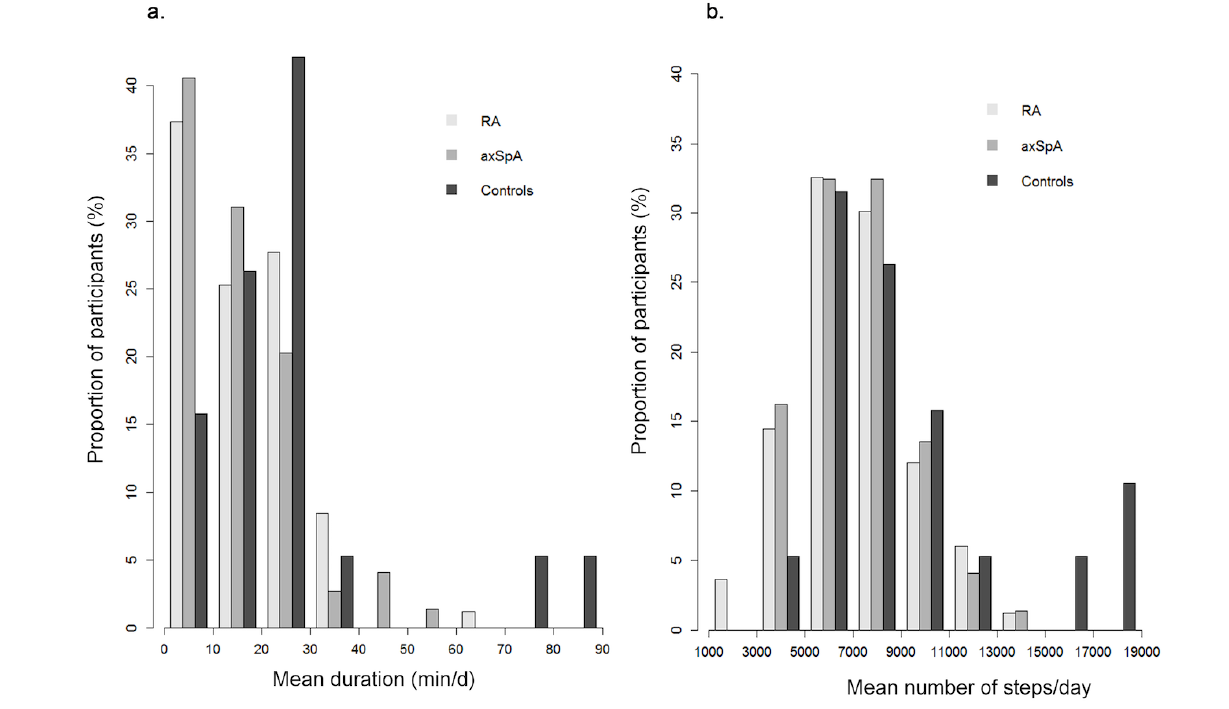
Figure 3. Distribution of mean physical activity over 3 months in 83 RA, 74 axSpA and 19 controls: (A) mean duration of moderate to vigorous activity (min/d) and (B) mean number of steps per day. RA: rheumatoid arthritis; axSpA: axial spondyloarthritis.